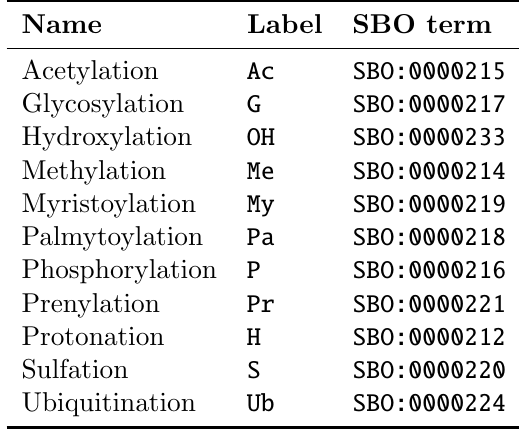
Table 2.4: A sample of values from the covalent modifications vocabulary (Section 2.2.3).